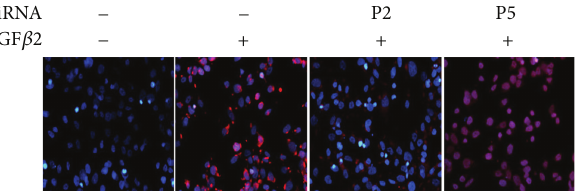
Figure 5: siRNA inhibition of Snail protein expression. Serum starved HLEB3 cells were transfected with human Snail siRNA (P2) and negative control (P5) before being stimulated with TGF 𝛽 2 for 8 hours. Cells were stained with anti-Snail antibody (red) and counterstained with Hoechst (blue). Images were taken by fluorescence microscope (400x).